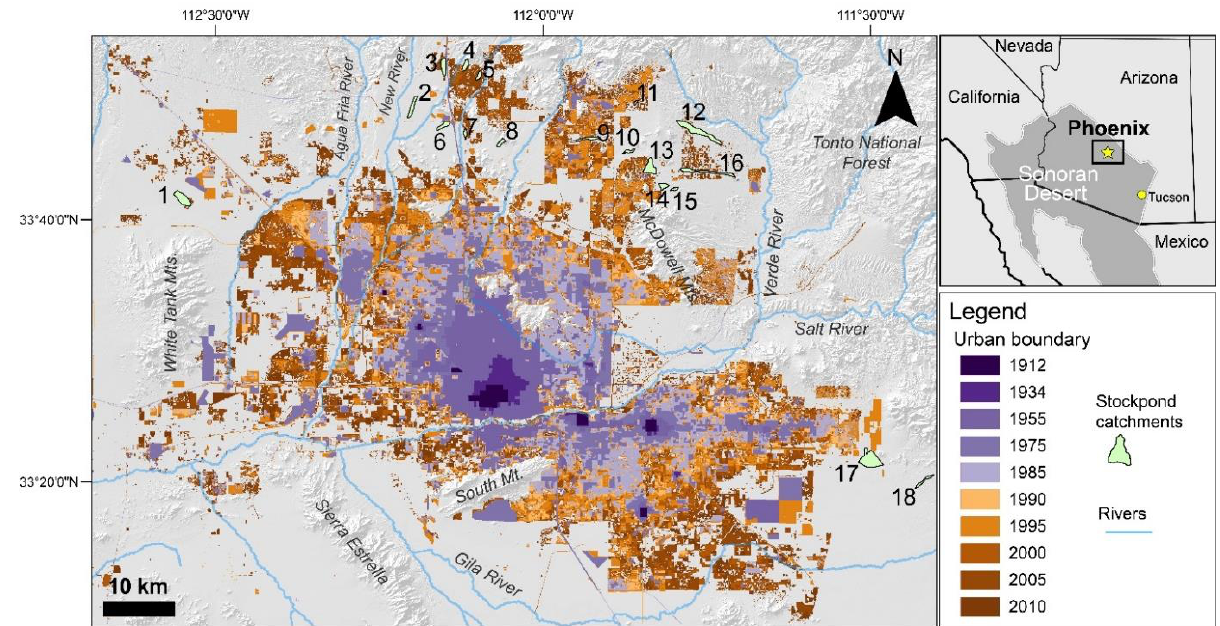
Figure 1. Topography of Arizona, United States with the studied watersheds found within the box. This study area occurs in the climatological Sonoran Desert and within a geological Basin and Range Province where the Salt, Verde, and Gila rivers flow through the Phoenix metropolitan region, Arizona, United States.